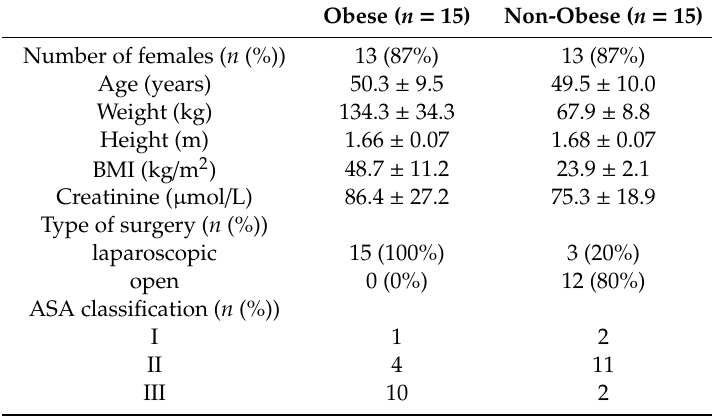
Table 1. Patient characteristics. Entries are the mean ± standard deviation or numbers (%). BMI = body mass index.